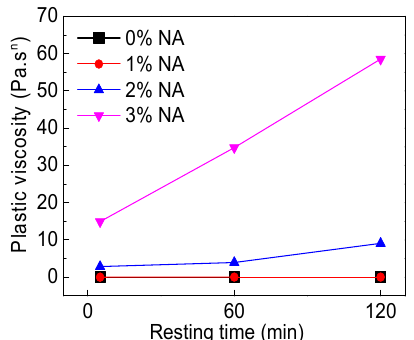
Figure 27. Influence of resting time on K.